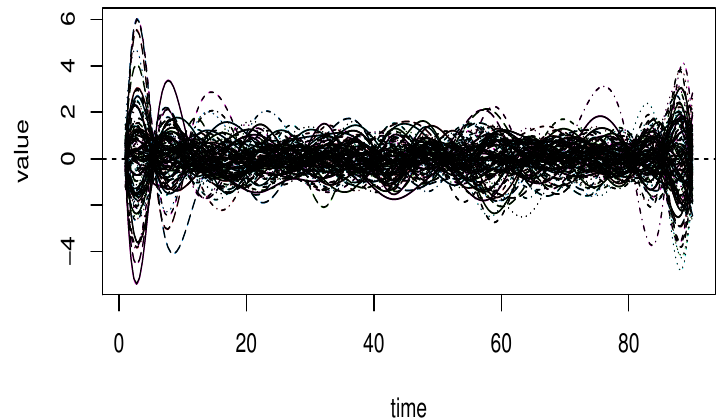
Figure 5. The smoothed curves; the case when R =